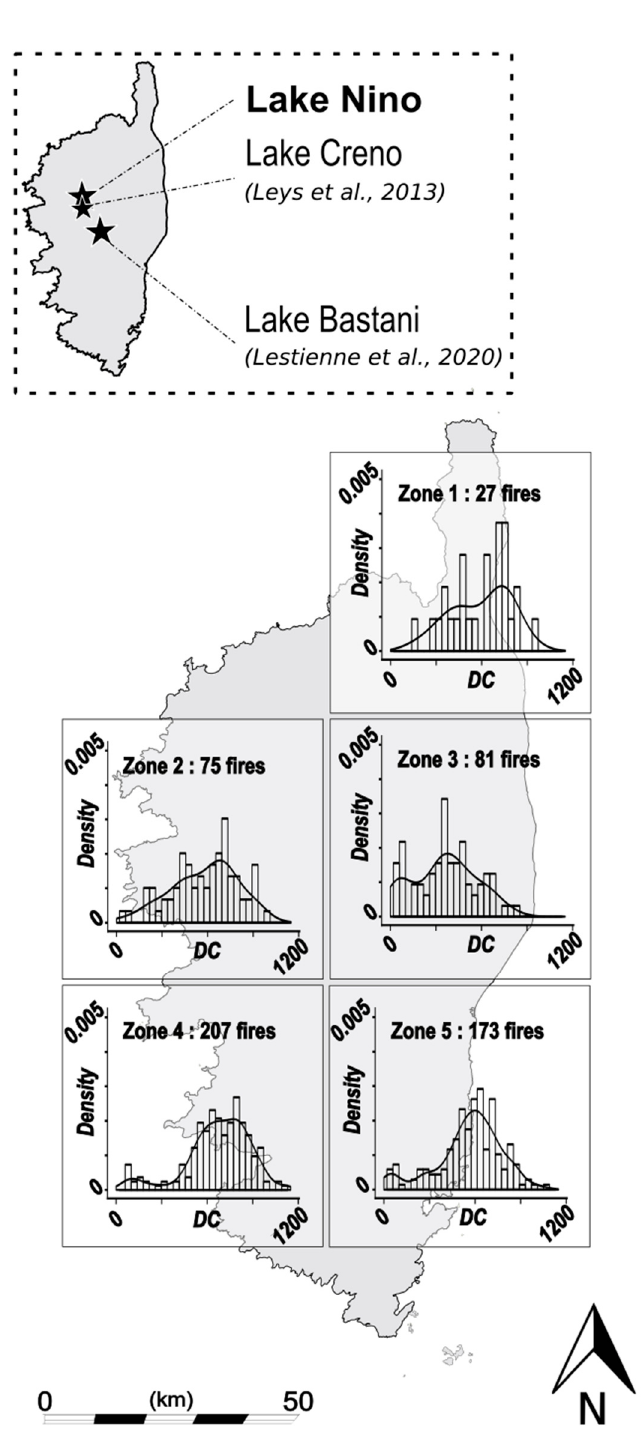
Figure A2. The high spatial variability in terms of fire occurrences reported since 1979 in Corsica (the southern region recording more fires than the northern part [10]) and the related distribution of the DC values for fire-days from the five ERA-Interim pixels covering Corsica.